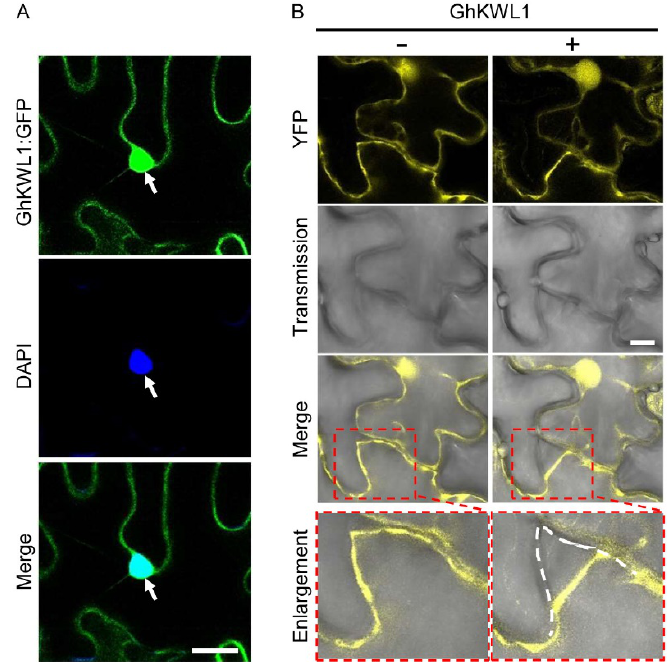
Figure 1. The subcellular localization of GhKWL1. ( A ) Colocalization of the GhKWL1:GFP fusion protein with DAPI-stained nucleus in tobacco ( Nicotiana benthamiana ) pavement cells. Agrobacterium tumefaciens infiltration solution containing the pro35S : GhKWL1 : GFP vector was infiltrated into tobacco leaves. After 3 d, the infiltrated leaves were stained with DAPI for 20 min, and the fluorescence signals were observed. The white arrows indicate the nucleus. DAPI, a fluorescent dye of DNA. Merge, overlay of green and blue fluorescence images. ( B ) Subcellular localization of GhKWL1:YFP after plasmolysis. Agrobacterium tumefaciens infiltration solution containing the pro35S : GhKWL1 : YFP vector was infiltrated into tobacco leaves. After 3 d, the infiltrated leaves were imaged ( − ) and then treated with 30% ( w / v ) sucrose solution (+) for plasmolysis. Merge, overlay of fluorescence and transmission images. Regions enclosed in the red boxes are enlarged in the bottom panel. The white dotted line represents the cell wall. Scale bars represent 50 μm (in ( A )) and 25 μm (in ( B )).